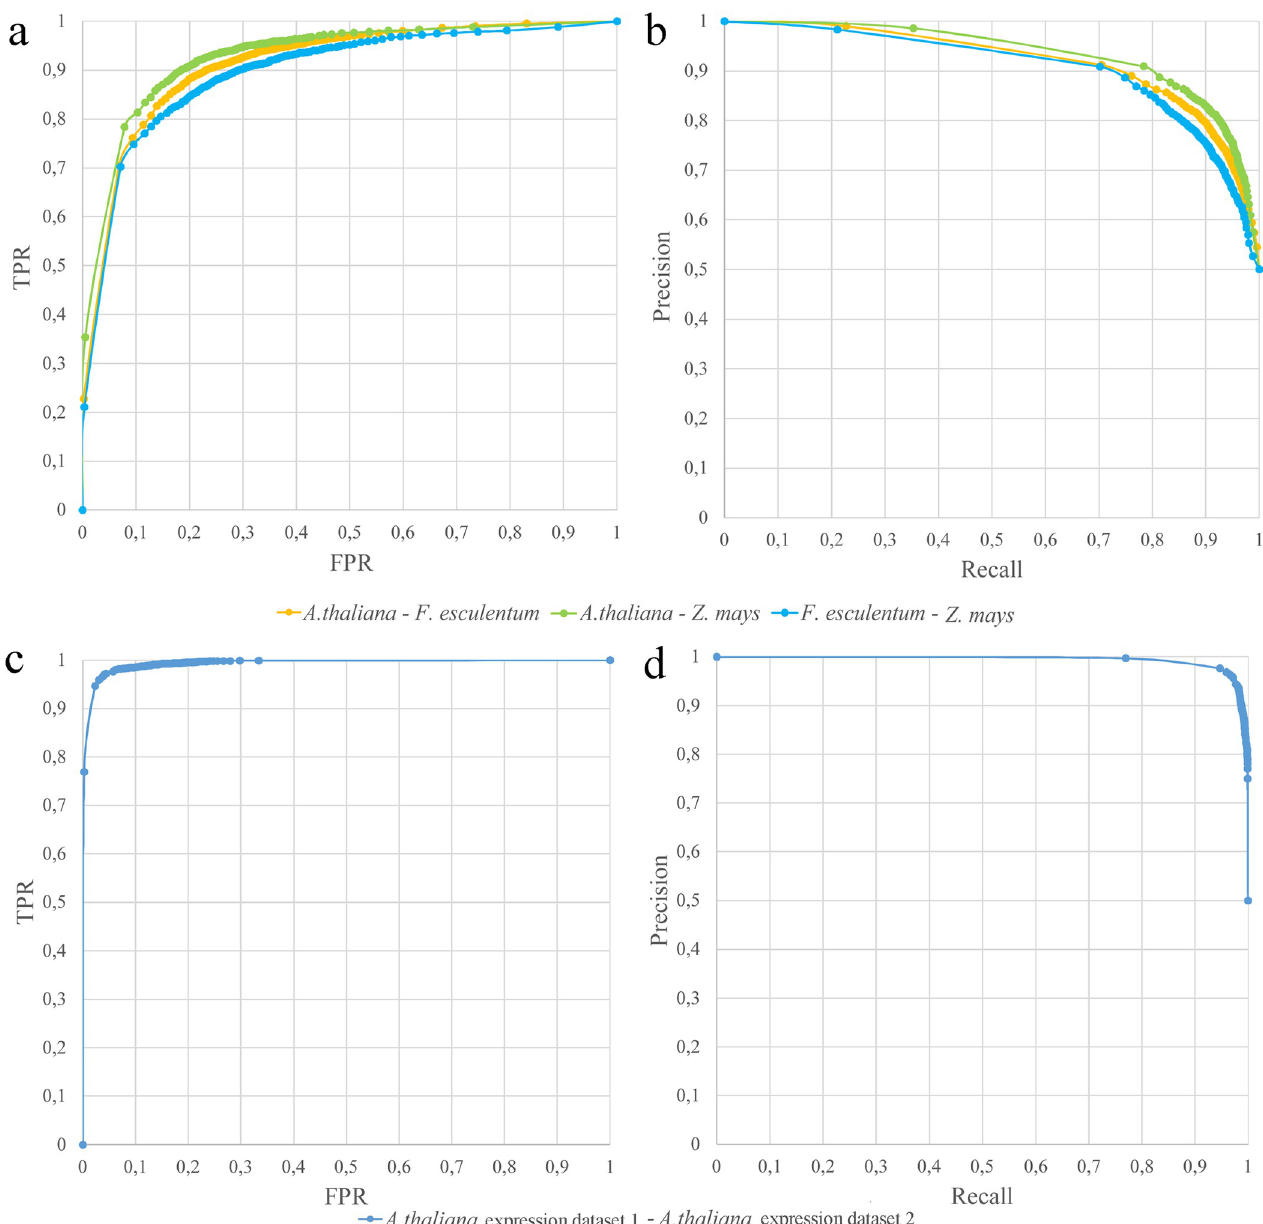
Fig 5. Results of ISEEML classifier at different evolutionary distances. (a) ROC curves for the ISEEML pipeline applied to three interspecific pairs: Arabidopsis–buckwheat, Arabidopsis–maize, buckwheat–maize. (b) Precision-recall curves for the same pairs. c: ROC curve for the ISEEML pipeline applied to the pair Arabidopsis-Arabidopsis where different sets of transcriptome samples were taken as a source of information on expression profiles. d: Precision- recall curve for the same input data as in c.